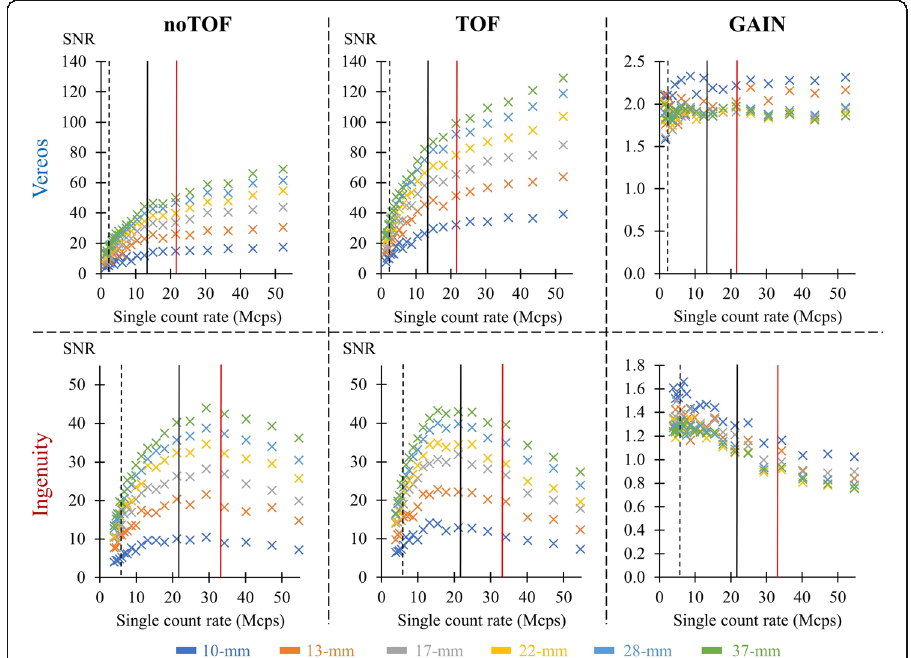
Fig. 4 Single-count rates versus signal-to-noise ratios (SNR) of the 10 to 37-mm diameter hot spheres of the IEC phantom for the noTOF (left panels) and TOF (median panels) images from the Vereos (upper panels) and Ingenuity (lower panels) cameras, together with the corresponding TOF-related gain, i.e., the ratio between the SNR of TOF and noTOF images (right panels). The dashed and solid vertical black lines correspond to respectively the lower and upper levels of single-count rates for the PET exams performed with the injections of 3 MBq.kg -1 . The solid red vertical line corresponds to the estimated upper level of single-count rates for the PET exams performed with the injections of 5 MBq.kg